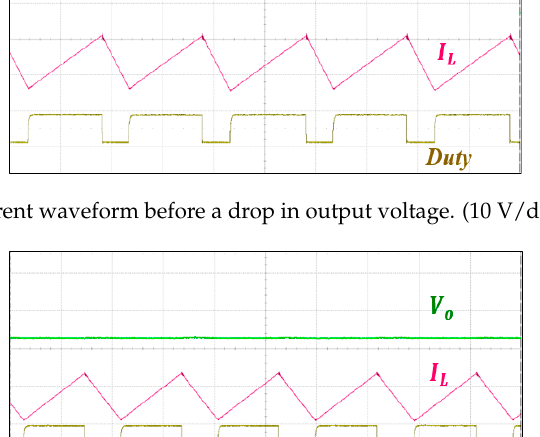
Electronics 2018 , 7 , x FOR PEER REVIEW 13 of 15 Figure 26. Inductor current waveform after a drop in output voltage. (10 V/div, 1A/div, 25 us/div).